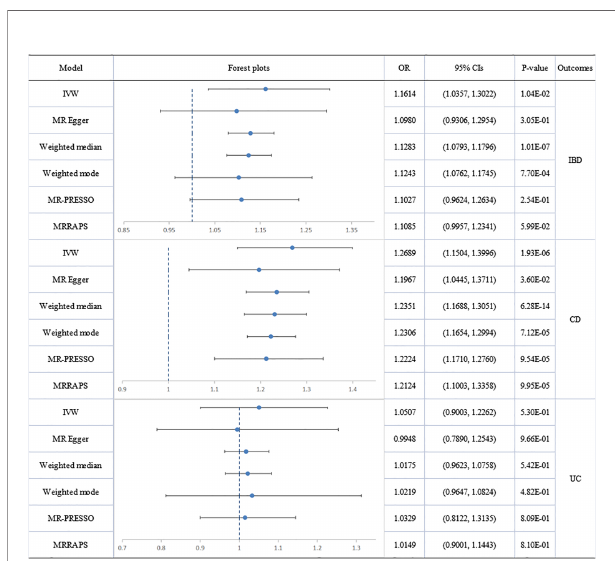
FIGURE 4 | Causal estimates given as odds ratios (ORs) and 95% con fi dence intervals for the effect of psoriasis on in fl ammatory bowel disease, Crohn ’ s disease and ulcerative colitis. IBD, in fl ammatory bowel disease; CD, Crohn ’ s disease; UC, ulcerative colitis; PSO,